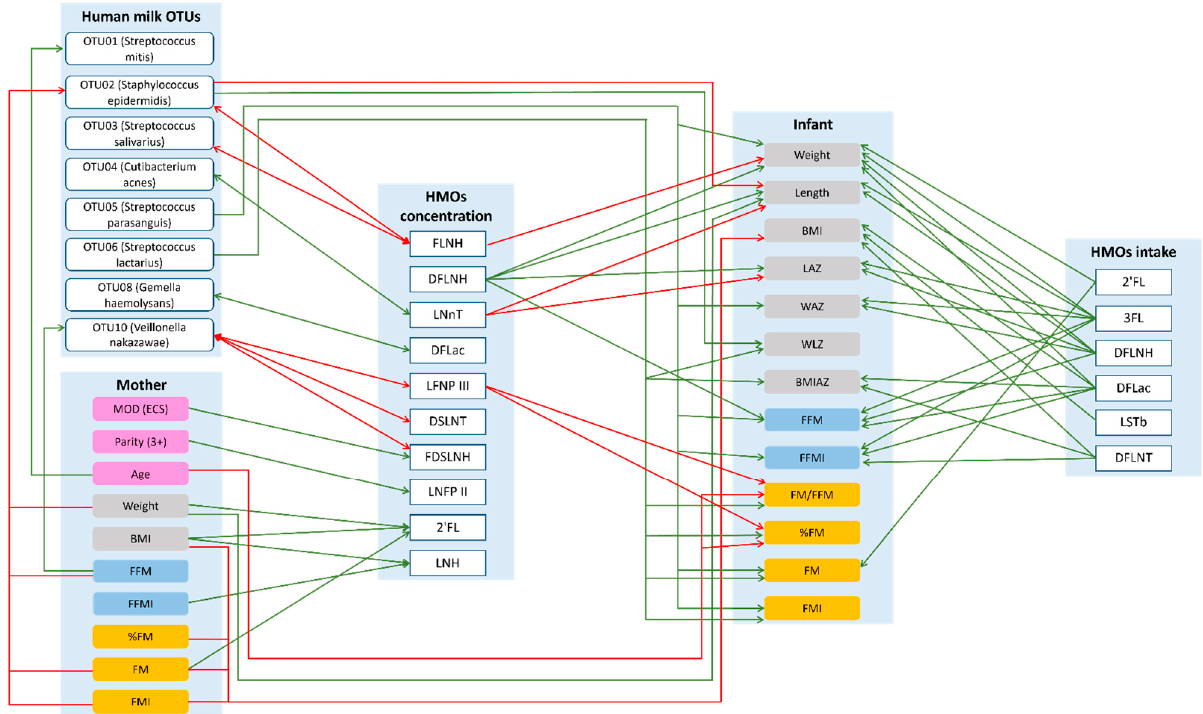
Figure 3. Possible lactocrine programming of the infant body composition irrespective of maternal secretor status. Green arrows indicate positive and red arrows indicate negative associations. 2 ′ — 2 ′ -fucosyllactose; 3FL—3-fucosyllactose; BMI—body mass index; BMIAZ—BMI-for-age z-scores;